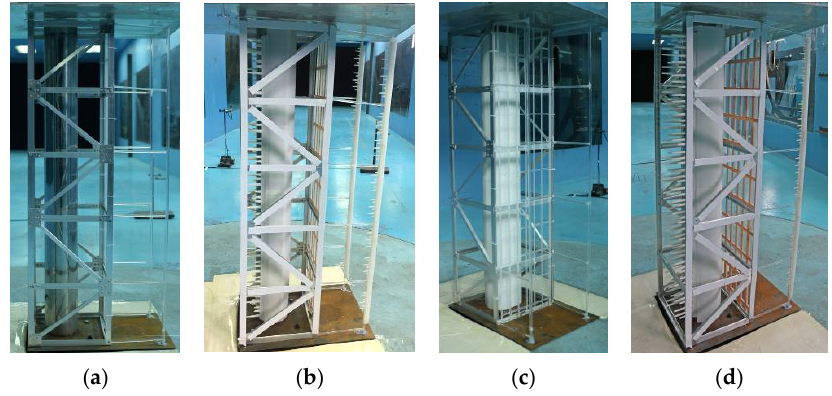
Figure 24. Pipeline girder sectional models: ( a ) ice-free, ( b ) crescent-shaped ice for C4, ( c ) D-shaped ice for C1, and ( d ) sector-shaped ice for C4.